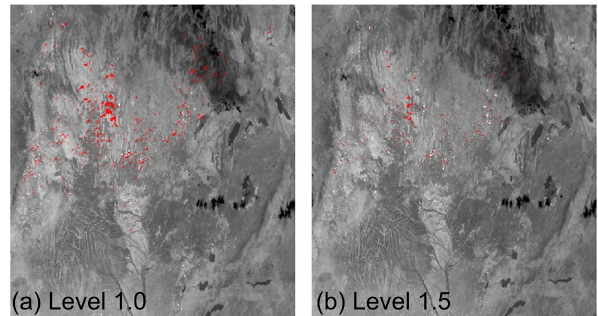
Figure 11. Impact of IR3.9 channel saturation in SEVIRI level 1.0 and level 1.5 data. Typically, a maximum of only a few percent of active fire pixels are saturated in any particular SEVIRI image, but the exact proportion is dependent on data pre-processing lev- els. Here, in red we show the spatial distribution of saturated active fire pixels in (a) level 1.0 and (b) level 1.5 SEVIRI data collected over a 2-day (48h) period in a region of Southern Africa (16 and 17 July 2014). Twice as many pixels are saturated in the level 1.0 over these 2 days (shown by a 10-bit DN of 1023; n = 2797) than are apparent in the level 1.5 data (shown by a maximum brightness temperature recordable in the IR3.9 band; n = 1390). The back- ground imagery on which the saturated pixels are displayed is an IR3.9 image acquired on 17 July at